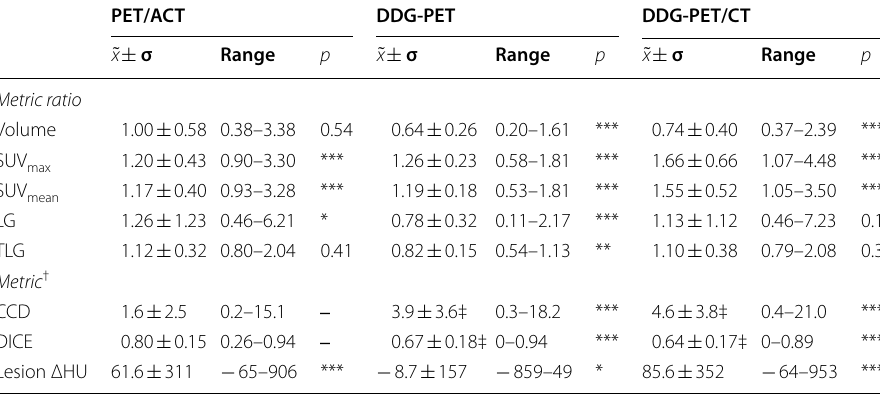
Table 2 Statistical summary of metrics used in this study